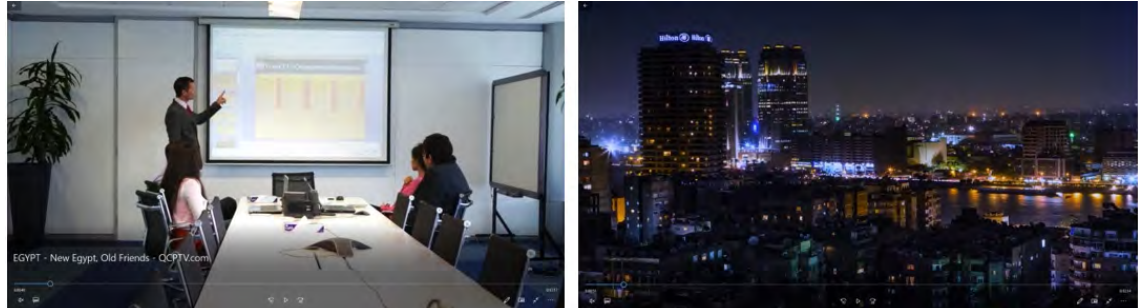
Figure 21. The quality in sosaity life , work & live (New Egypt Old Friends,